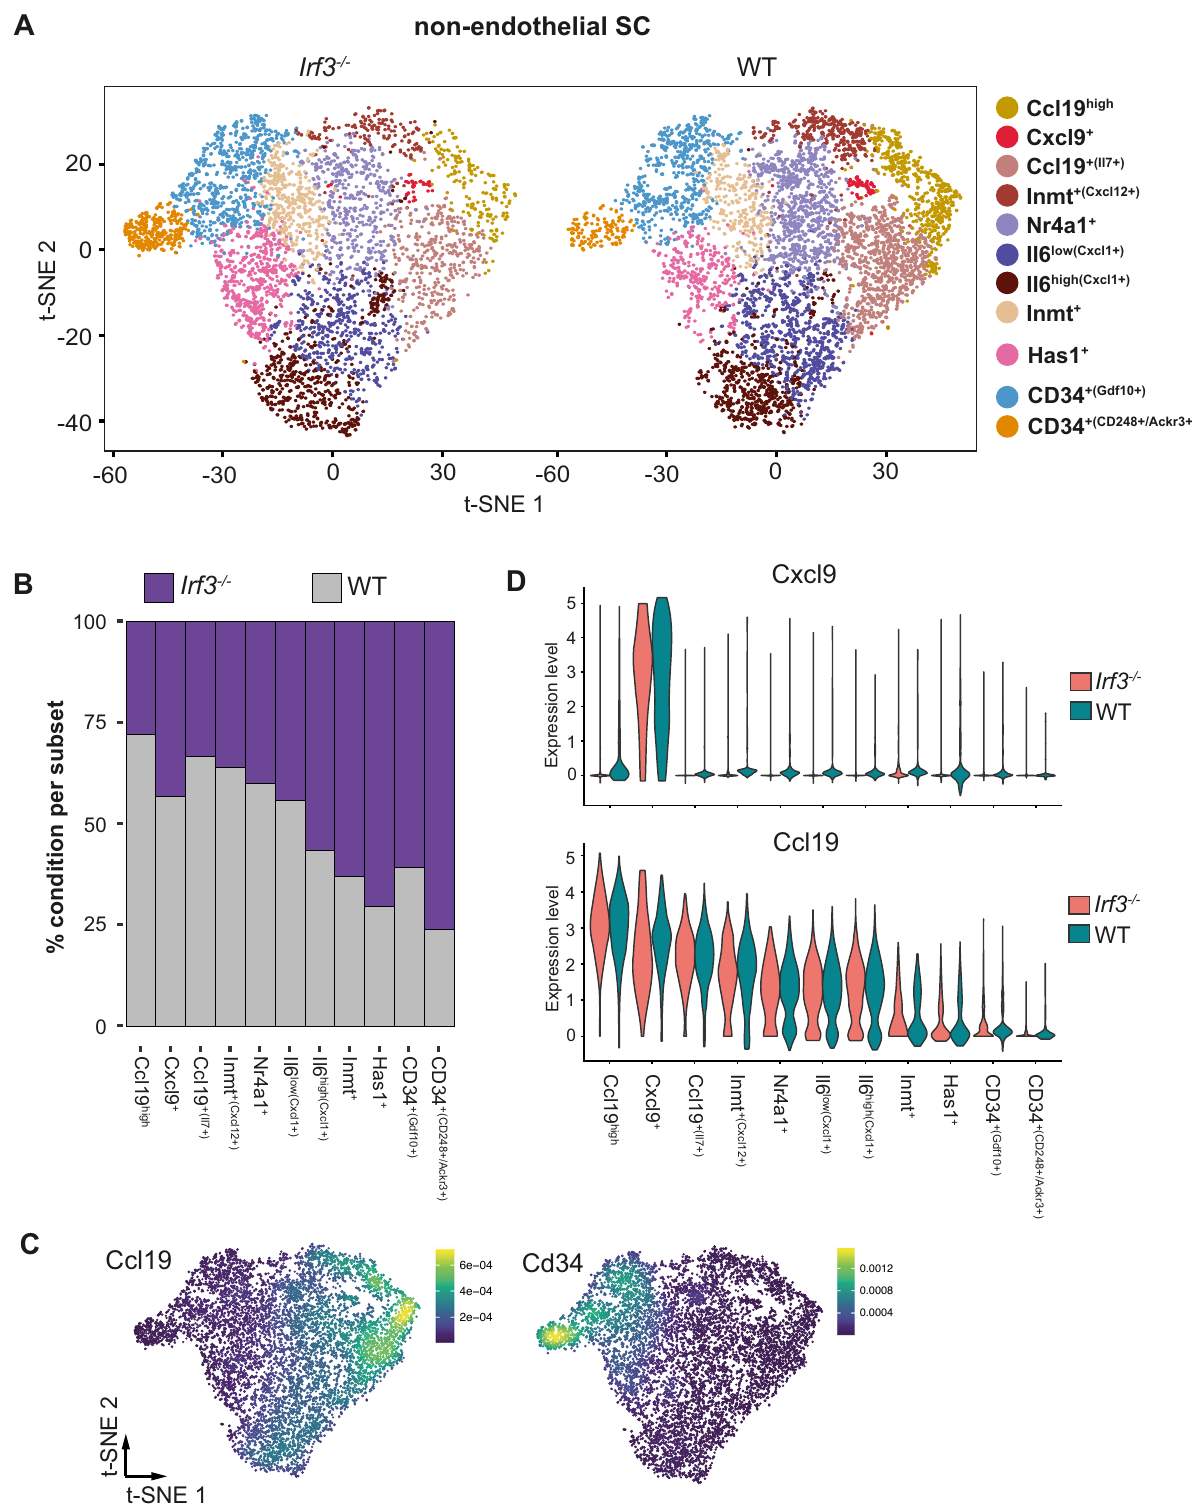
Fig.7| Irf3 de fi ciencyleadstoashiftoftheSCsubsetcompositionmarkedbya reductionofCxcl9 + andCcl19 + FRCsubsets. CD45 - CD24 - cells were isolatedfrom mLNs and pLNs of 9 – 13 weeks old Irf3 − / − and WT male mice, and subjected to scRNA-seq analysis. One replicate was performed per condition. Non-endothelial SCs were identi fi ed as non-LECs, non-BECs, and non-PvCs. A t-SNE plot of inte- grated pLNSCs and mLNSCs showing cluster segregation of non-endothelial SC subsets between Irf3 − / − mice and WT controls. B Bar graph showing the propor- tion of cells within each subset normalized to total cell number belonging to